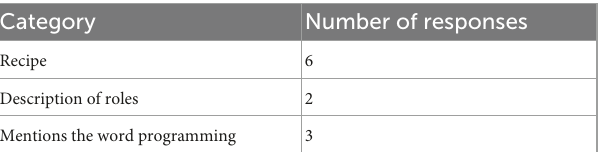
TABLE 2 Number of responses in two categories that cannot be directly linked to programming to the questions that asked how students experienced the programming in mathematics and food and